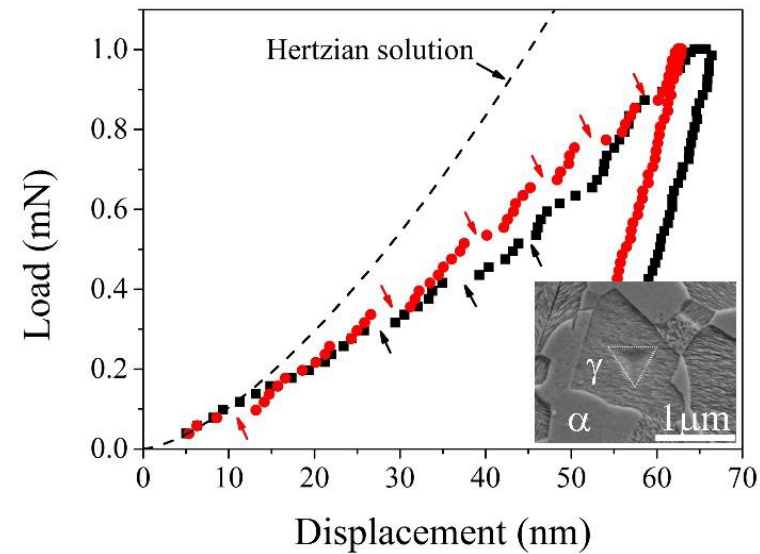
Figure 10. The load–displacement curve of indents on austenite grains in a medium Mn steel (Fe-7.16Mn-0.14C-0.23Si in wt.%). The arrows mark the pop-in. The lower right inset shows the indent on a single austenite grain.